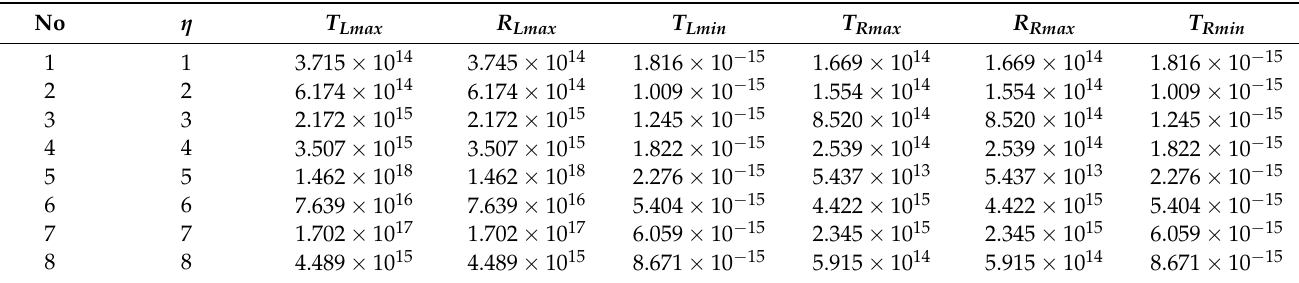
Table 1. Left (right) transmission and reflection peak/valley value of 8 1D PTSPROWNs of G = 1 and η = 1 − 8, as determined by the first extremum spontaneous PT-symmetric breaking